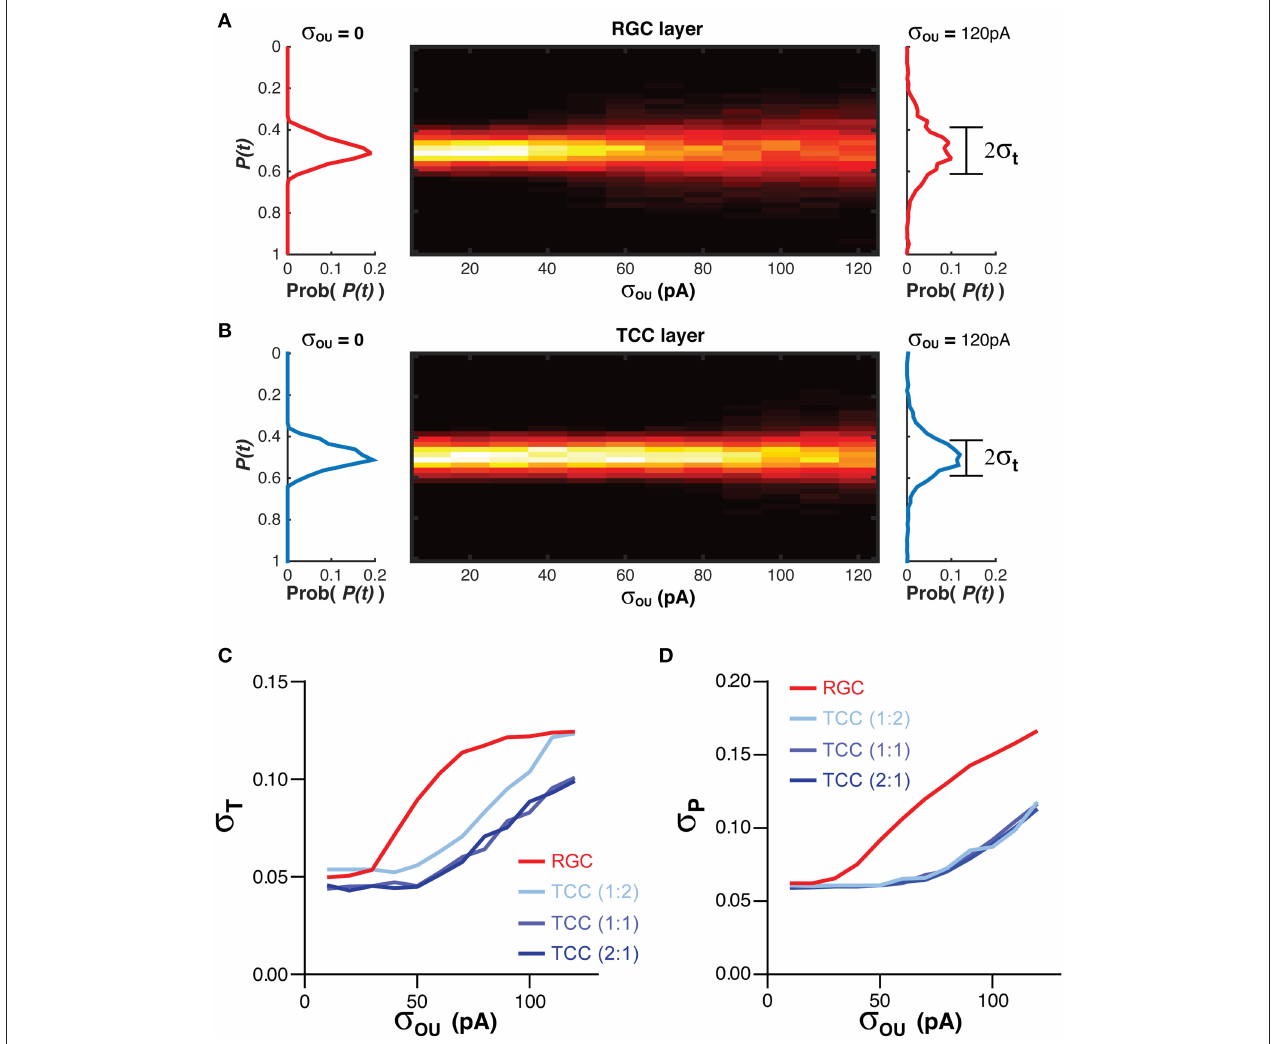
FIGURE 3 | Integration by TCCs increases the accuracy of the sensory coding in the presence of noise. (A) To the left and right of the heat map are histograms showing the distribution of the decoded position of the stimuli [P(t)] in the RGC layer, in the presence of no retinal noise ( σ OU = 0 ) and a large degree of retinal noise ( σ OU = 120 pA). The central heat map shows the distribution of P(t) across a range of retinal noise. Note the broadening of the distribution of P(t) as the amplitude of the retinal noise increases. (B) The same data as presented in (A) , but for the TCC layer. Again, as the noise in the RGC layer increases, the distribution of P(t) broadens, but to lesser degree. (C) The effect of network architecture (the ratio of TCCs to RGCs) and retinal noise on the distribution of P(t) ( σ T ). As retinal noise increases, in both the RGC and TCC layers, σ T increases, but over most of the parameter space, the TCC layer has a significantly lower value of σ T , that is, the encoding of position is more stable over time. (D) The effect of network architecture and retinal noise on the accuracy of encoding ( σ P ). Again, retinal noise causes worse performance in both layers but the thalamic layer performs better at all but the lowest levels of retinal noise. However, the ratio of TCCs to RGCs has no effect on